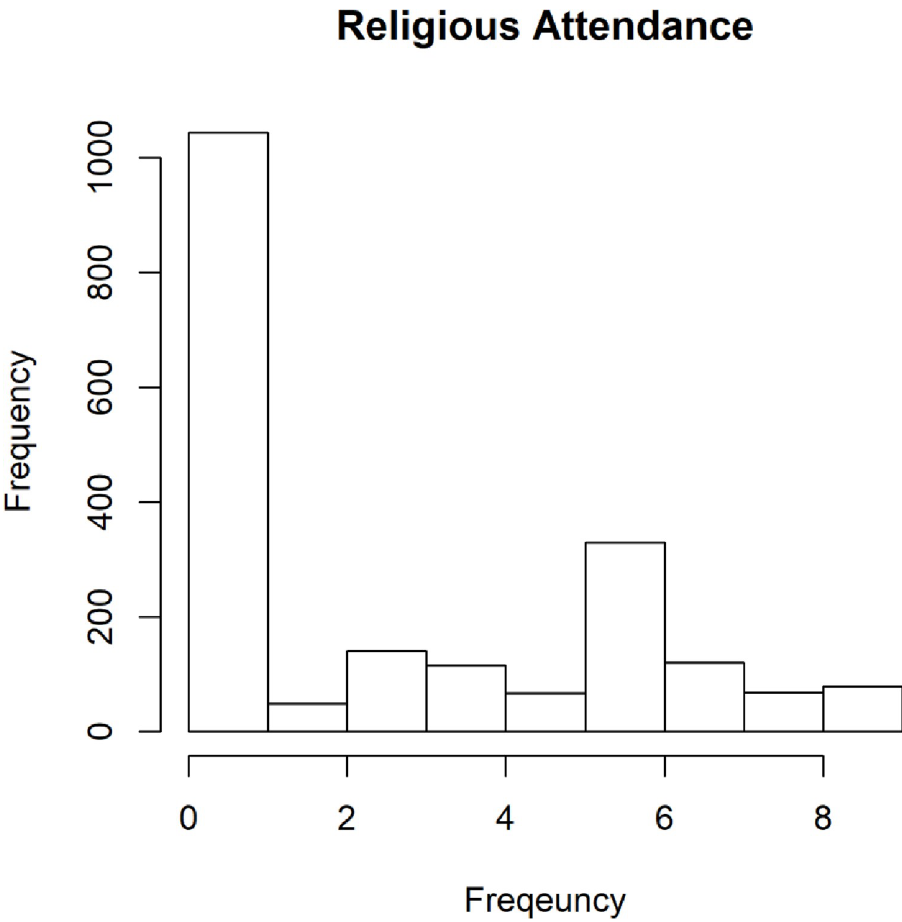
Fig 1. Distribution of frequency of religious